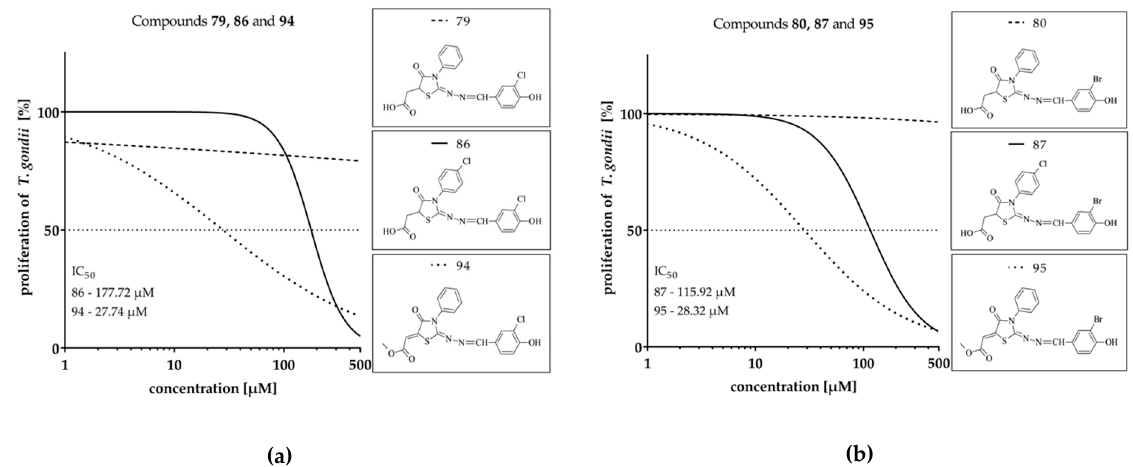
Figure 4. ( a ): Dose response curves and IC 50 values ( μ M) of 79, 86, and 94 on T. gondii proliferation. ( b ): Dose response curves and IC 50 values ( μ M) of 80, 87, and 95 on T. gondii proliferation.